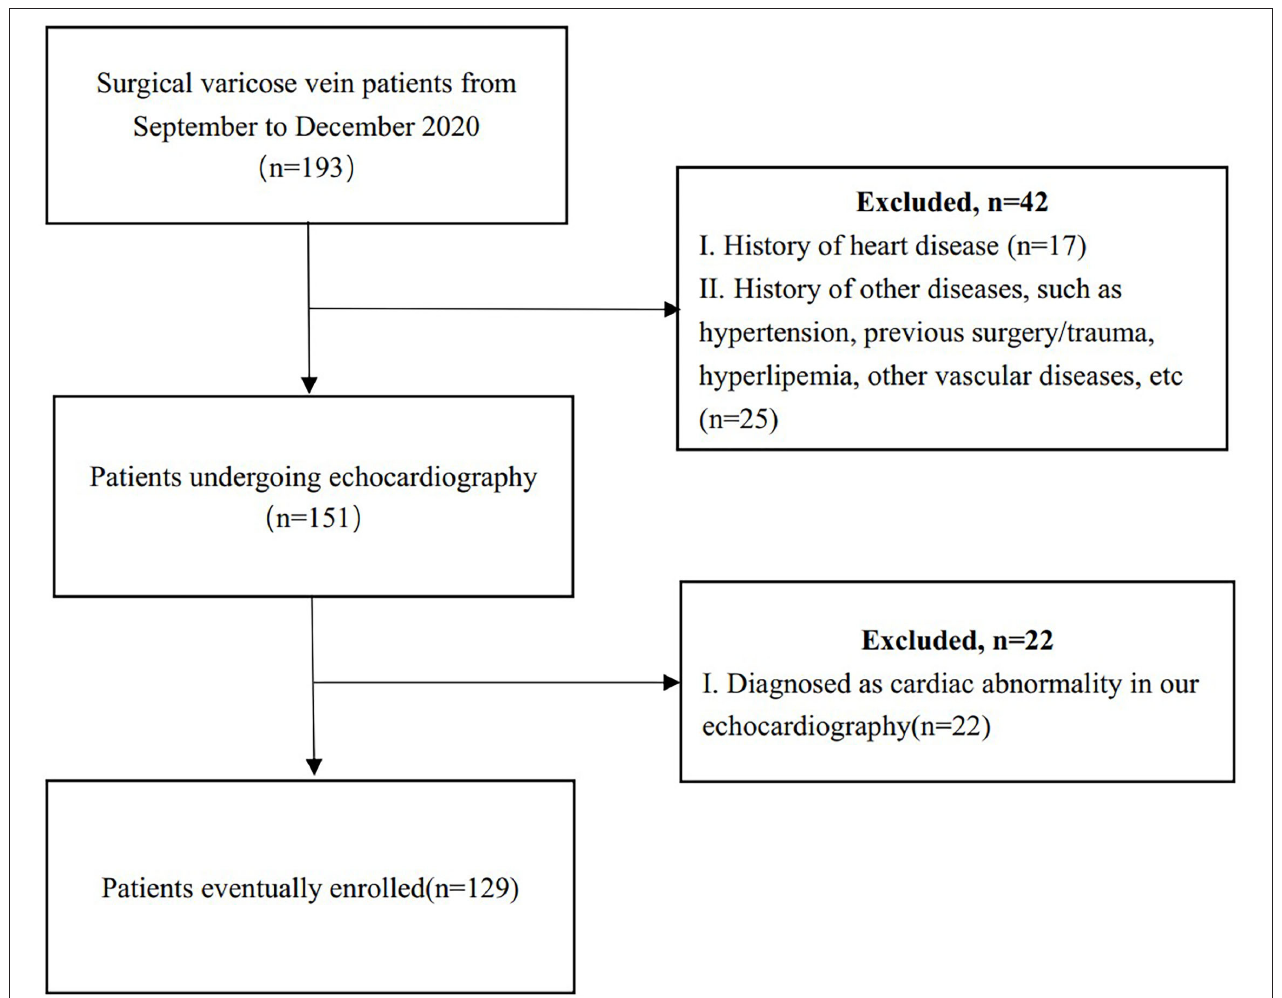
FIGURE 1 | The inclusion and exclusion flow chart of patients with primary lower extremity varicose